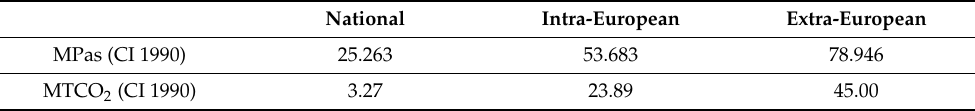
Table 5. Initial conditions (1990) for passengers and CO 2